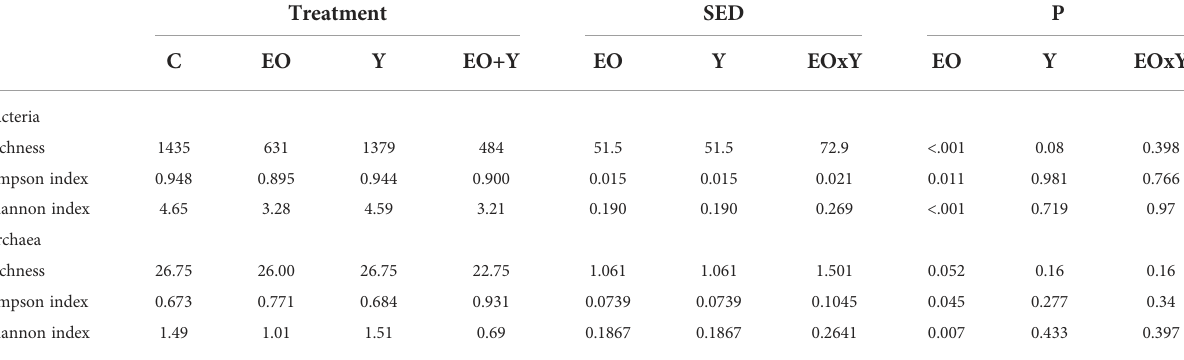
TABLE 5 Effect of supplementing a control diet (C) with oregano oil (EO), yeast (Y) or a combination of both (EO+Y) on the richness (number of OTUs) and diversity of the bacteria and methanogen communities in the RUSITEC system. Treatment